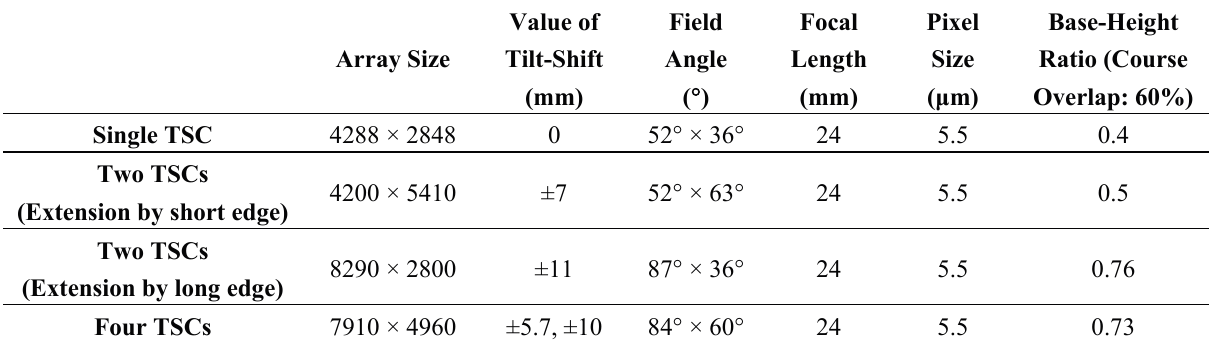
Table 1. Parameters of Prototype System of novel